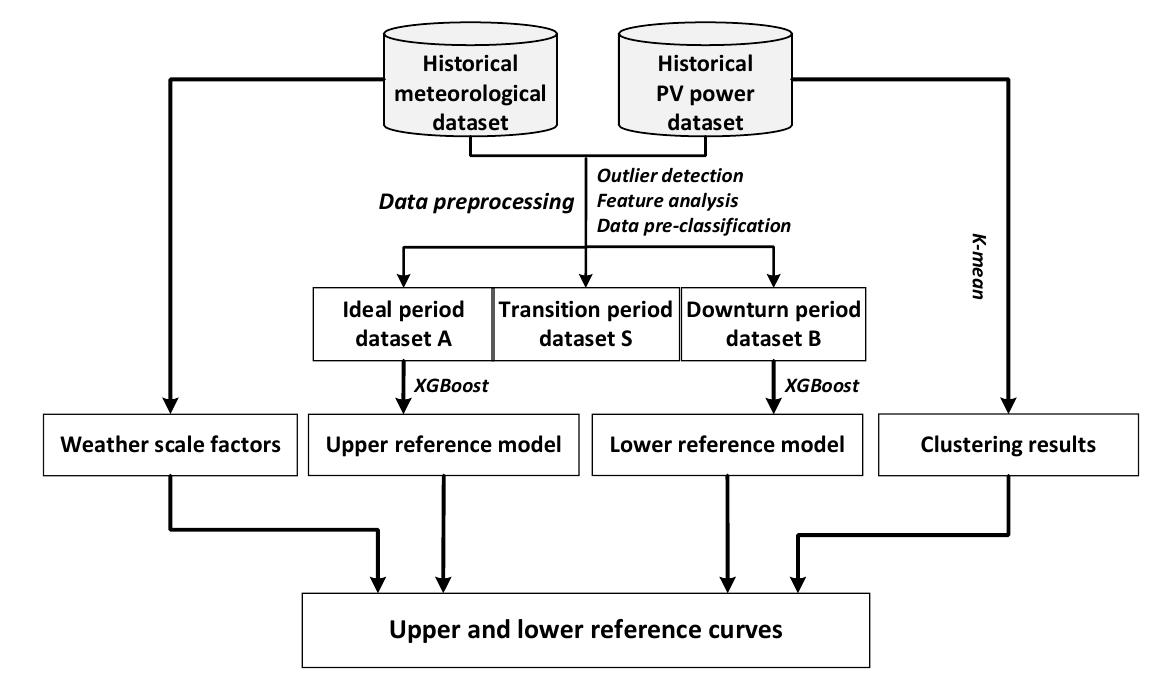
Figure 1. The general framework of the proposed method.